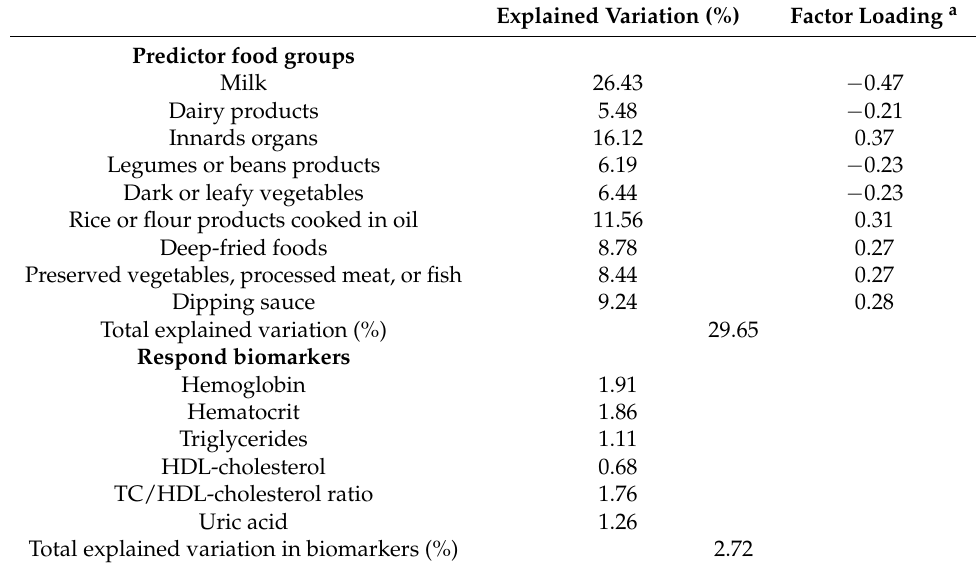
Table 3. Food groups that were associated with testosterone-related dietary pattern